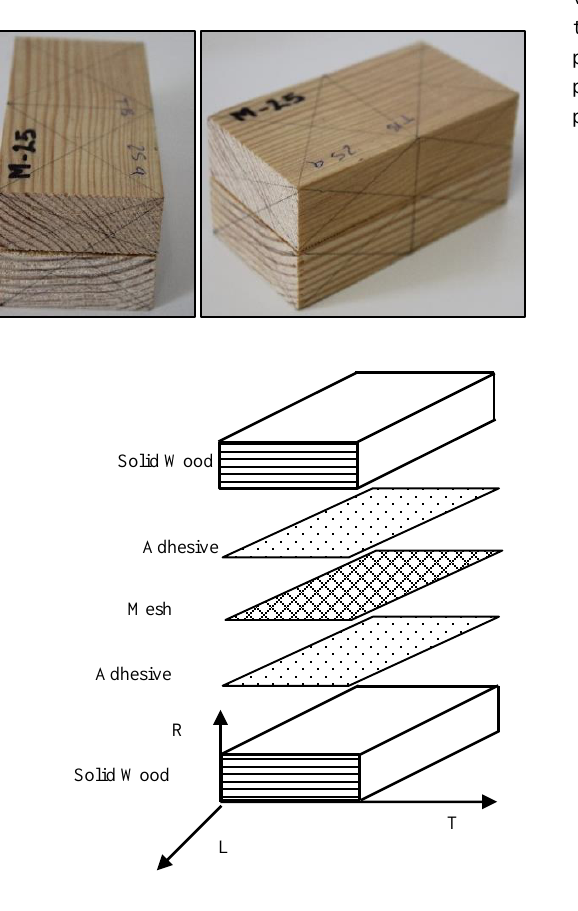
Figura 3. Multimaterial.